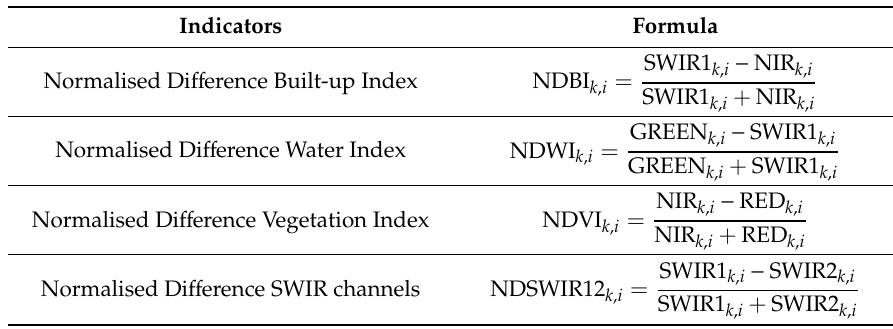
Table 3. Formulas of the four normalised ratios derived from each of the multi-spectral datasets. Each index is calculated within the temporal data series of each pixel i and K images, with K ∈ [1, N], being N the total number of